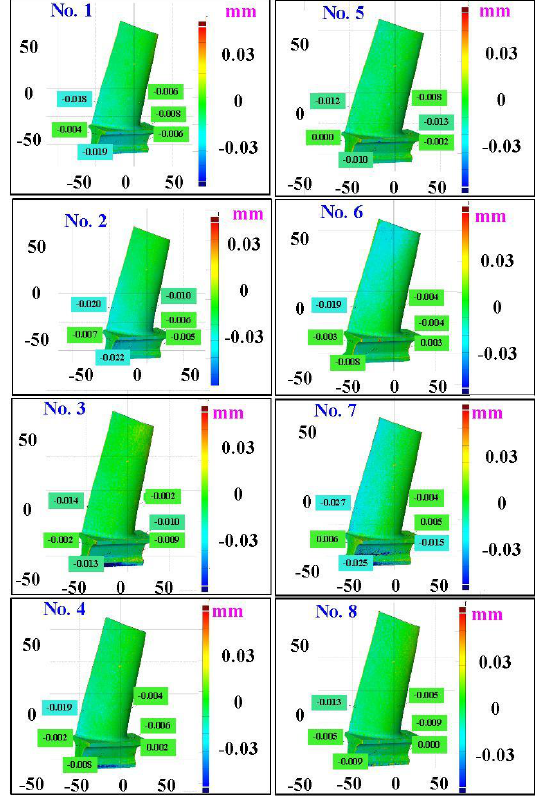
Materials 2022 , 15 , 6139 Figure 6. CAV results of the as-cast turbine blade. Figure 6. CAV results of the as-cast turbine blade.